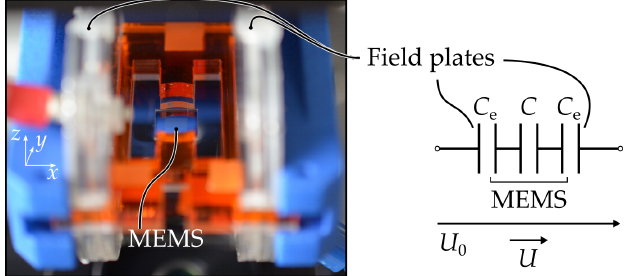
Figure 2. Equivalent circuit diagram of the E-field measurement setup. The ideal system can be understood as three capacitors connected in series and the electrostatic force exerted on the sensor as proportional to the square of the voltage drop at the centre capacitor C which corresponds to the sensing gap of the